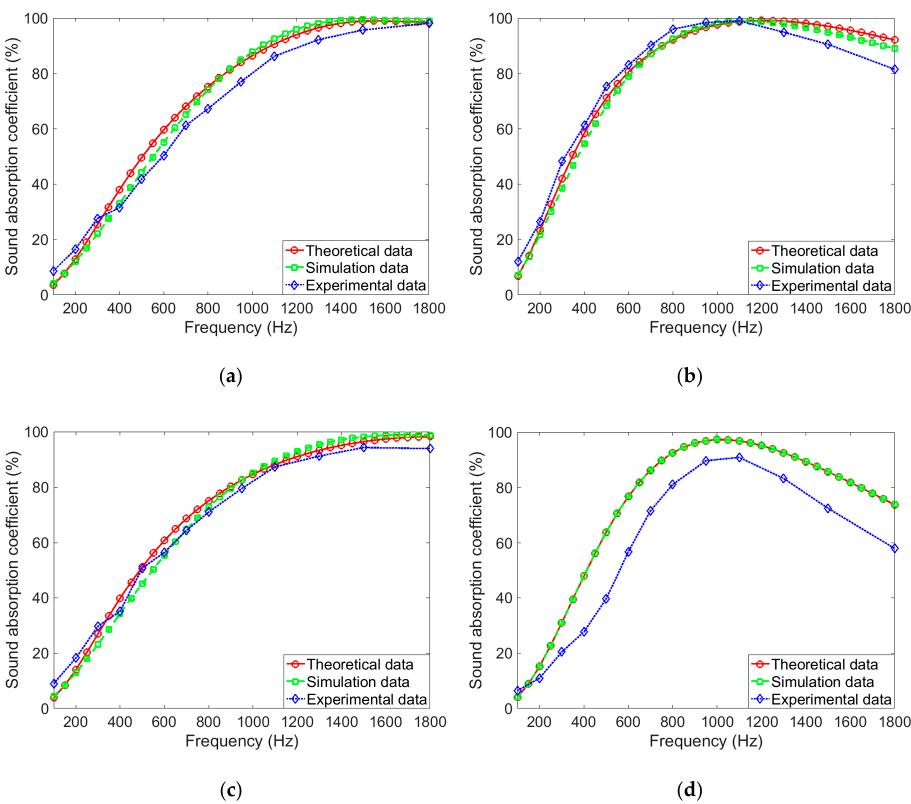
Figure 7. Comparisons of theoretical data, simulation data, and experimental data with the limited total thickness of 50 mm. ( a ) Porous metal + cavity + microperforated panel + cavity; ( b ) Microperforated panel + cavity + porous metal + cavity; ( c ) Porous metal + cavity; ( d ) Microperforated panel + cavity.